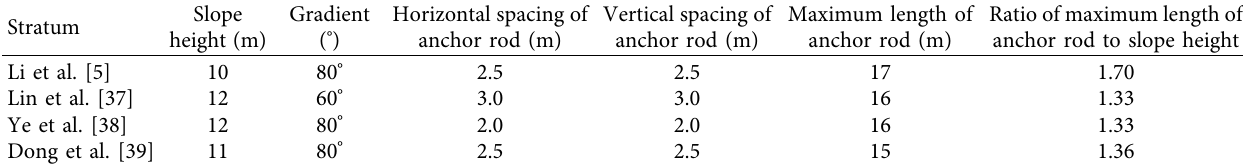
Table 4: Main parameters of single-stage loess slope supported by the frame structure with